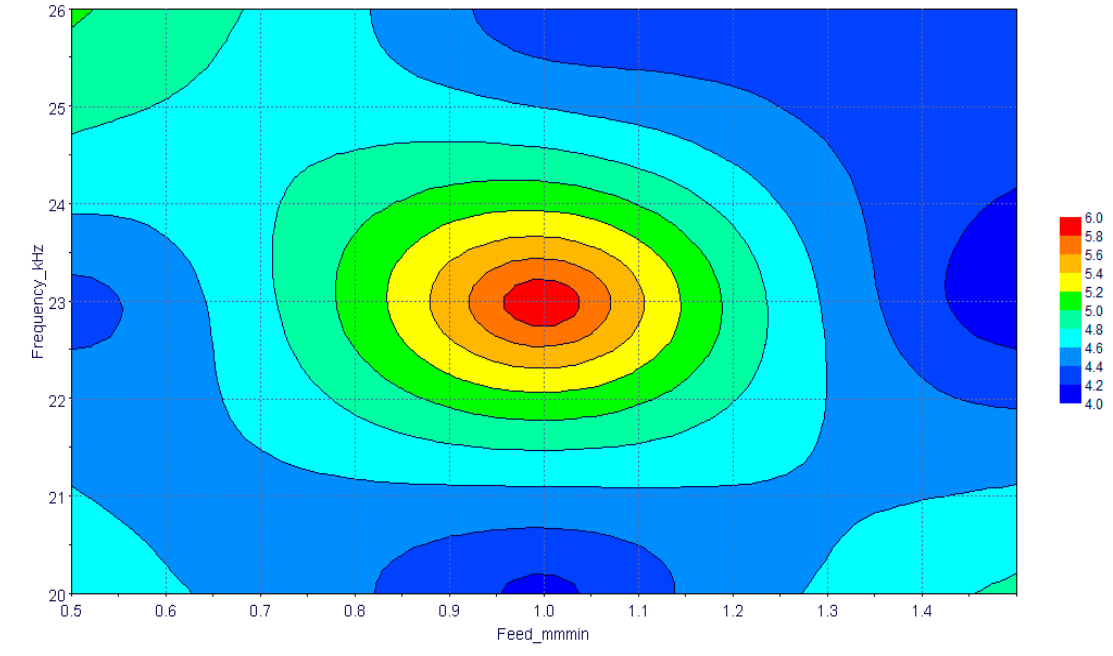
Figure 12. Combined effects of speed and feed rate on taperness.